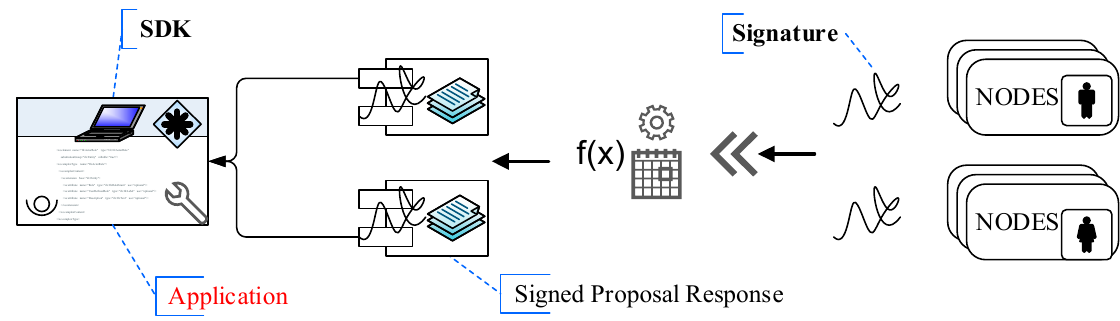
Figure 10. The response of the R nodes (building review authority) to the initial request.